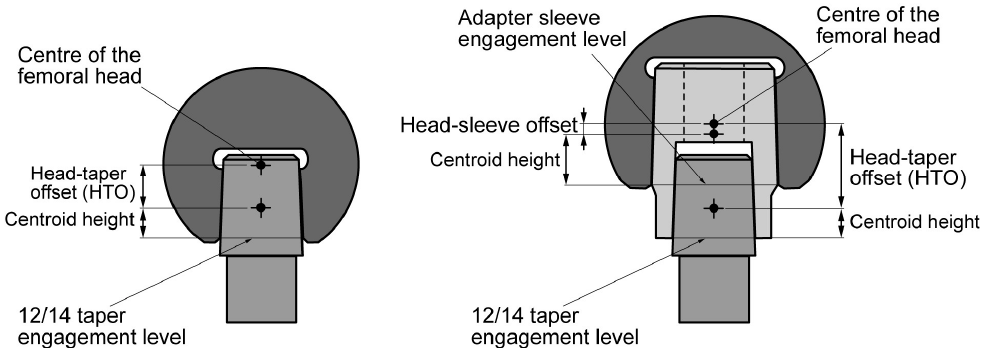
Figure 2. Left: head-taper offset when the head is assembled on a 12/14 male taper; Right: head-adapter sleeve and head-taper offset when an adapter sleeve is included.